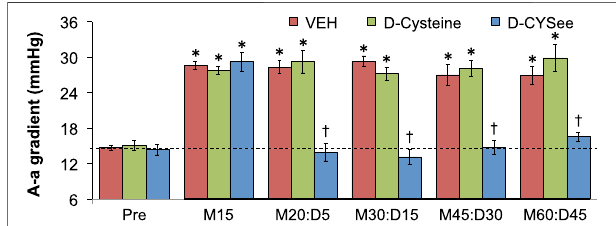
FIGURE 8 | Alveolar – arterial (A-a) gradient values before (Pre) and after injection of morphine (10 mg/kg, IV) in three groups of freely-moving rats followed by an injection of vehicle (VEH (saline), IV), D-cysteine (500 μ mol/kg, IV), or D-cysteine ethyl ester (D-CYSee, 500 μ mol/kg, IV). The terms M15, M20, M30, M45, and M60 denote 15, 30, 45, and 60 min after injection of morphine. The terms D5, D15, D30, and D45 denote 5, 15, 30, and 45 min after injection of drug (vehicle, D-cysteine, or D-CYSee). The data are mean ± SEM. There were 8 rats in the vehicle- or D-CYSee-treated groups and 6 rats in the D-cysteine – treated group. * p < 0.05, signi fi cant change from pre- values. † p < 0.05, D-CYSee versus